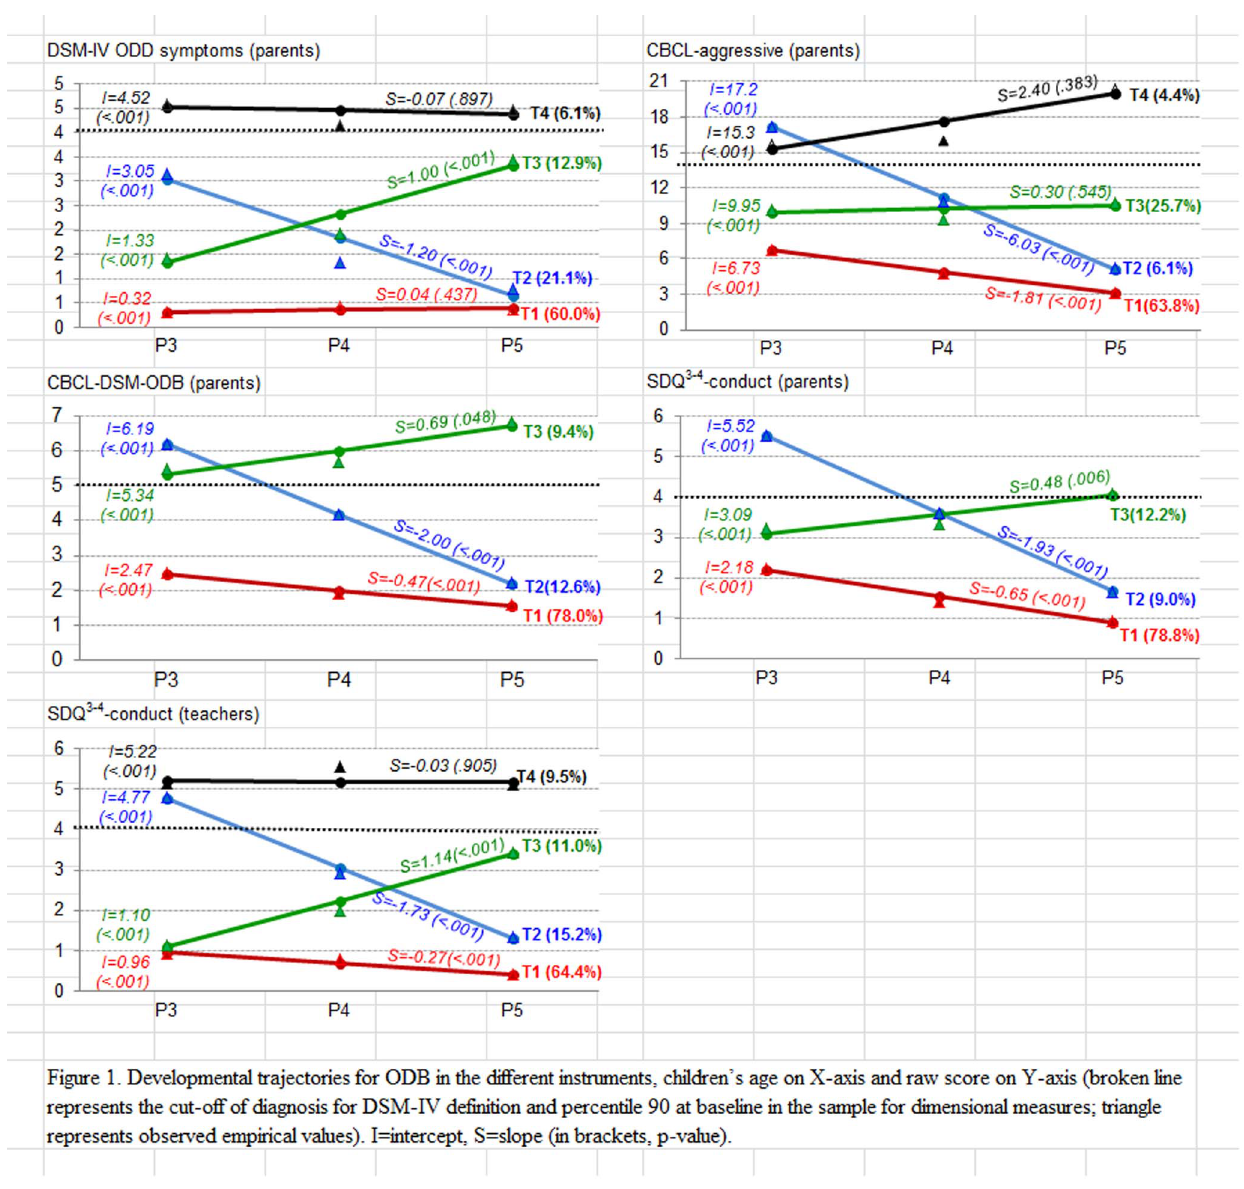
Figure 1. Developmental trajectories for ODB in the different instruments, children’s age on X-axis and raw score on Y-axis (broken line represents the cut-off of diagnosis for DSM-IV definition and percentile 90 at baseline in the sample for dimensional measures; triangle represents observed empirical values). S=slope (in brackets, p-value) .